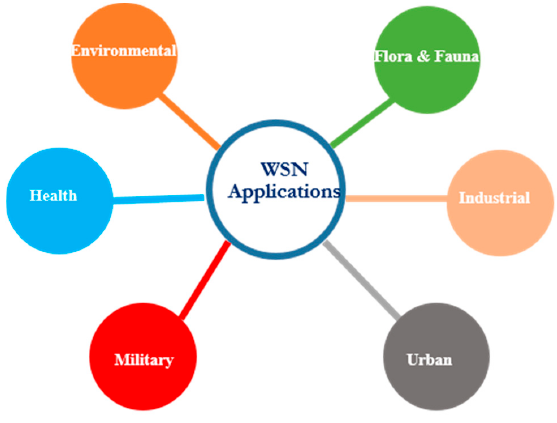
Figure 3. Overview of the most popular categories of applications of WSNs.